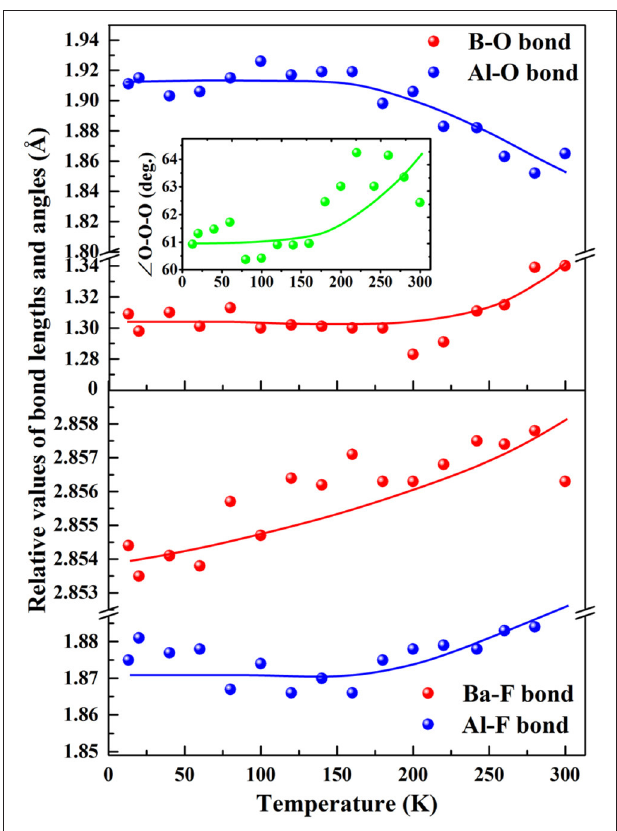
FIGURE 3 | Function of refined bond length and angles with respect to temperature in